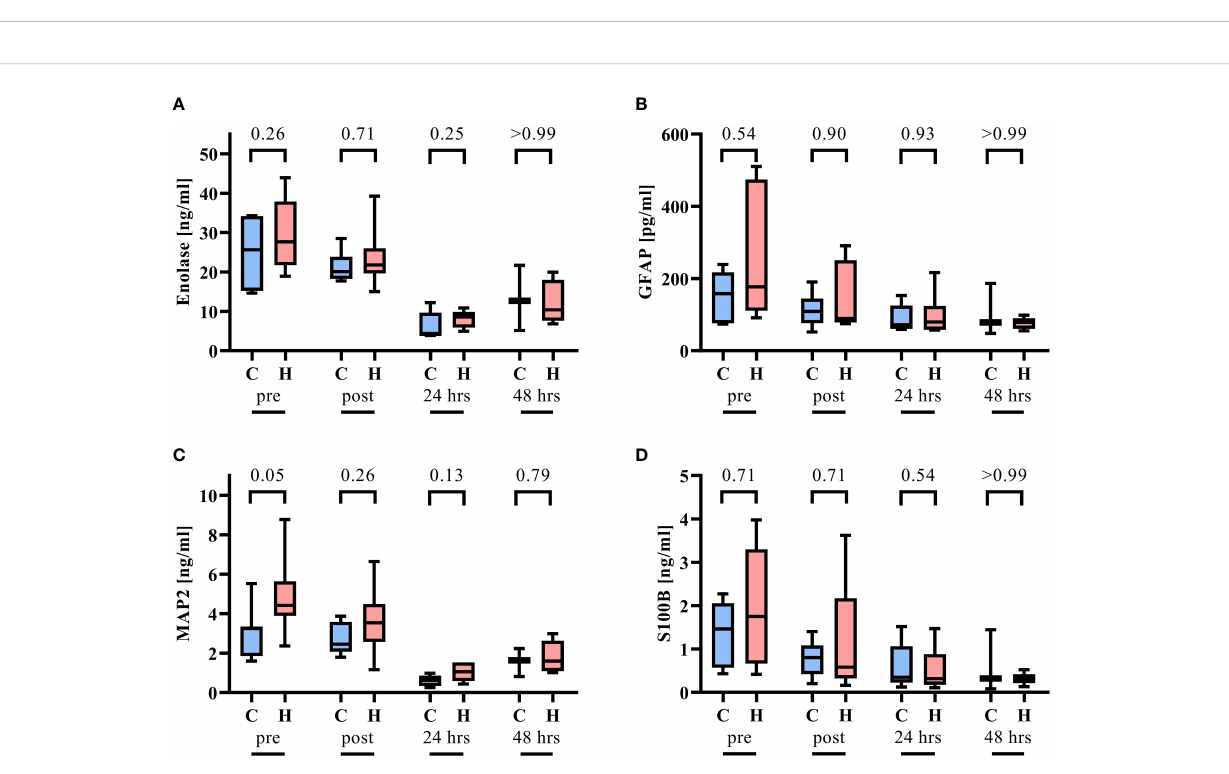
FIGURE 3 Parameters of neuronal injury before (pre) and after 2 hrs of hemorrhagic shock and acute subdural hematoma (post) as well as 24 hrs and 48 hrs after resuscitation n = 7/7 before shock, 7/7 after shock, 5/6 at 24 hrs, and 3/5 at 48 hrs per group for normoxemia (blue, control group, C) and targeted hyperoxemia (red, H), respectively. (A) Enolase, (B) porcine glial fi brillary acidic protein (GFAP), (C) porcine microtubule-associated protein 2 (MAP2), and (D) porcine S100 Calcium Binding Protein B (S100b). For MAP2 before shock and Enolase 24 hrs after resuscitation in the normoxemia group and GFAP post HS and ASDH in the hyperoxemia group, the 25 th percentile and the median are similar and therefore could not be graphed separately. Mann-Whitney U test. The box plots report the median, interquartile range, minimum, and